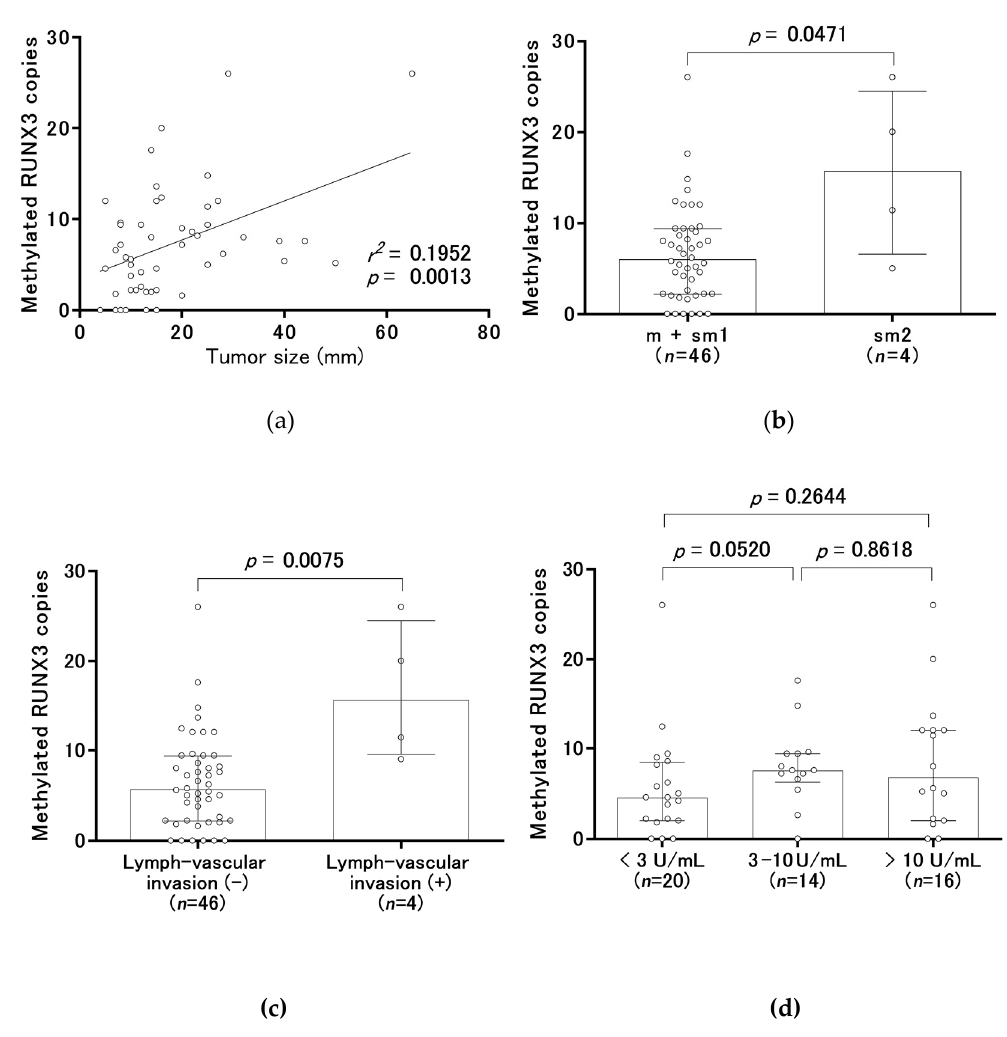
Figure 2. Distribution of methylated RUNX3 copy numbers. ( a ) The distribution of copy numbers of methylated RUNX3 is shown for each group. Open circles indicate the individual samples. The numbers of methylated RUNX3 copies per a DNA amount equivalent to that in 40 μ L of serum are shown. The box plots show the median and interquartile range (25th and 75th percentiles). ( b ) The receiver ‐ operating characteristic (ROC) curve analysis of copy numbers of methylated RUNX3 to discriminate between the control group and early gastric cancer group is shown.